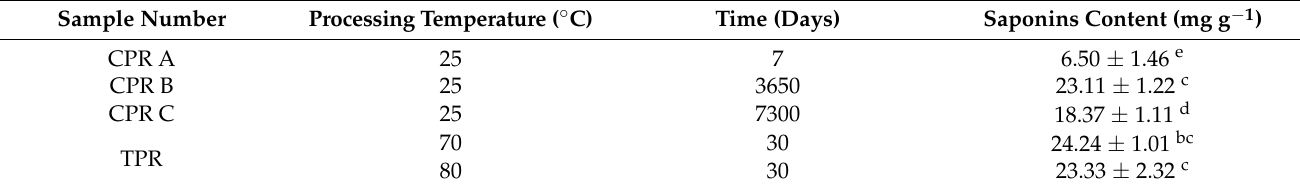
Table 1. The saponin content of thermal processing radish (TP) and commercial pickled radish (CPR). Sample